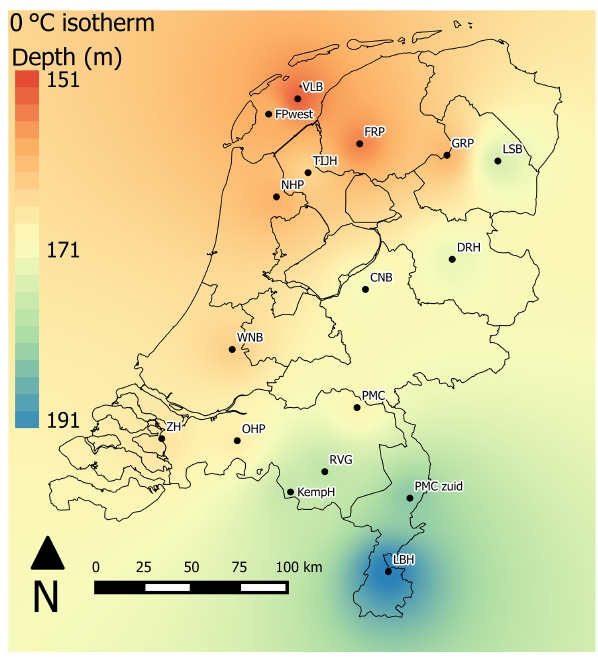
Figure 6. Interpolated best estimate maximum permafrost depth map for the 0 ◦ C isotherm. The pore water is assumed to be com- pletely in the liquid